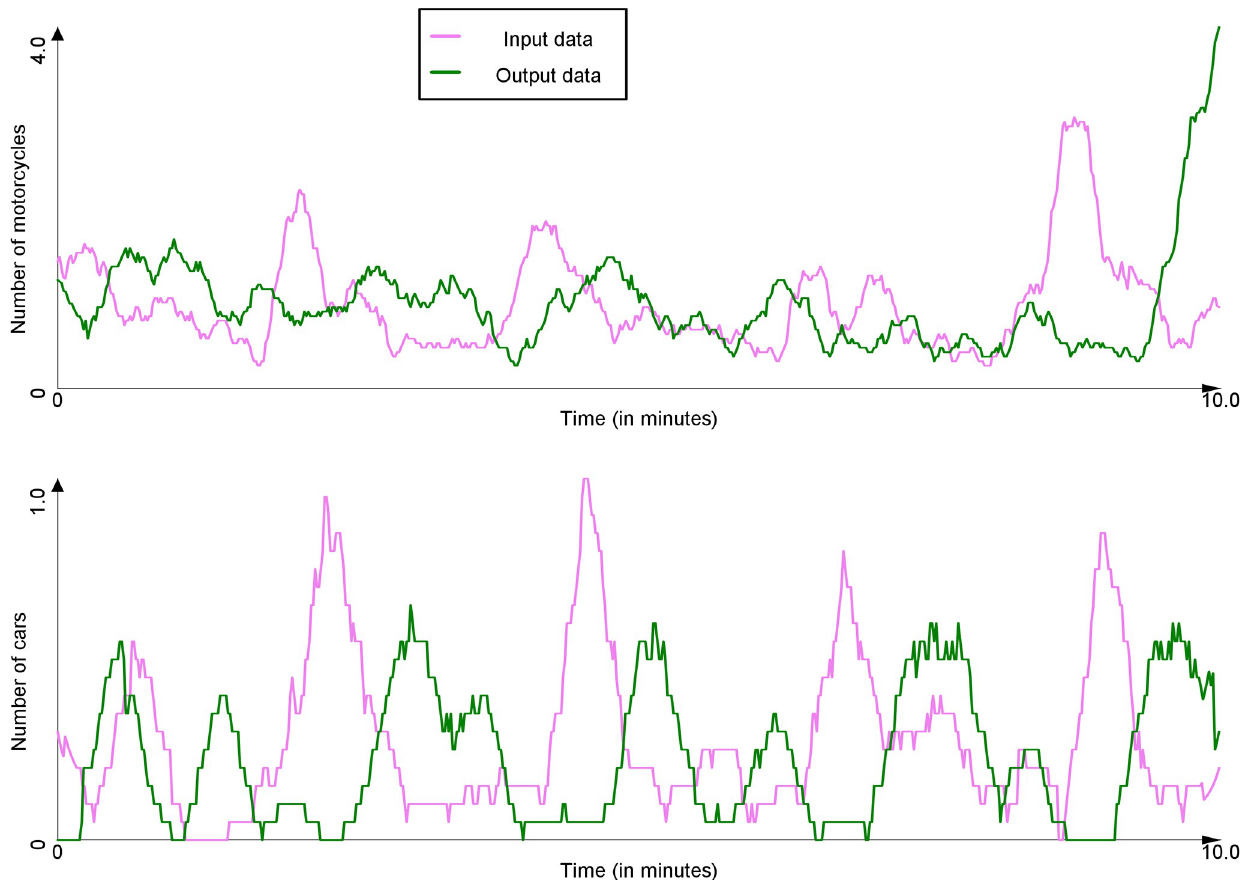
Fig 7. Count of vehicles at the input and output points for the Chua Boc site (time series were smoothed out using moving average with a window size of 10s).